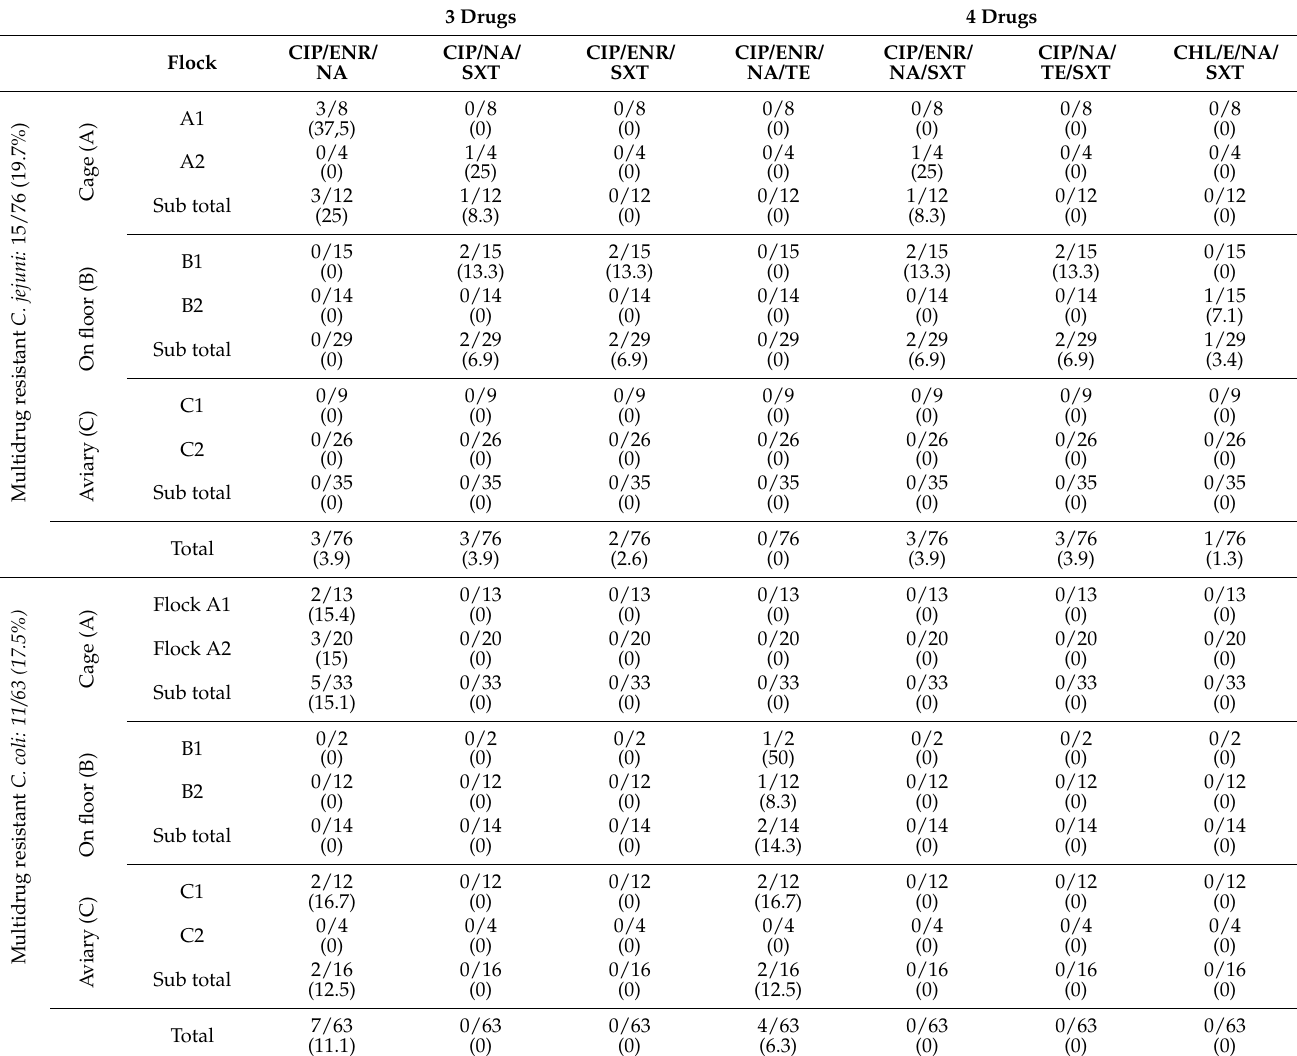
Table 5. Multidrug resistance found in C. jejuni and C. coli strains isolated from laying hens housed in enriched cages (A), barns (B) and aviaries